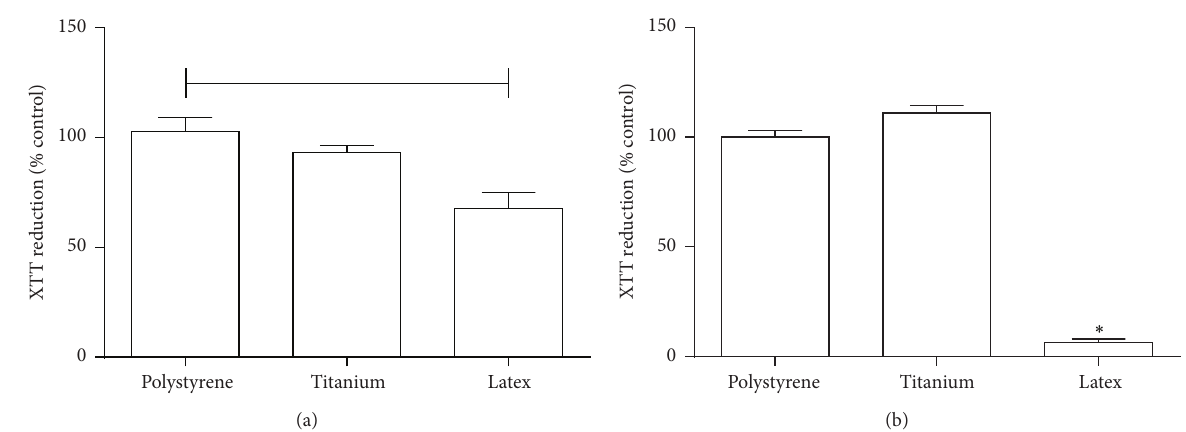
Figure 5: Cytocompatibility assay (XTT) performed with (a) MC3T3-E1 cells at 30,000 cells in three-dimensional culture or (b) HOb spheroids at 50,000 cells’ density. A line between bars indicates significant difference between groups ( 𝑝 < 0.05 ). An asterisk indicates significant difference from all other groups ( 𝑝 < 0.05